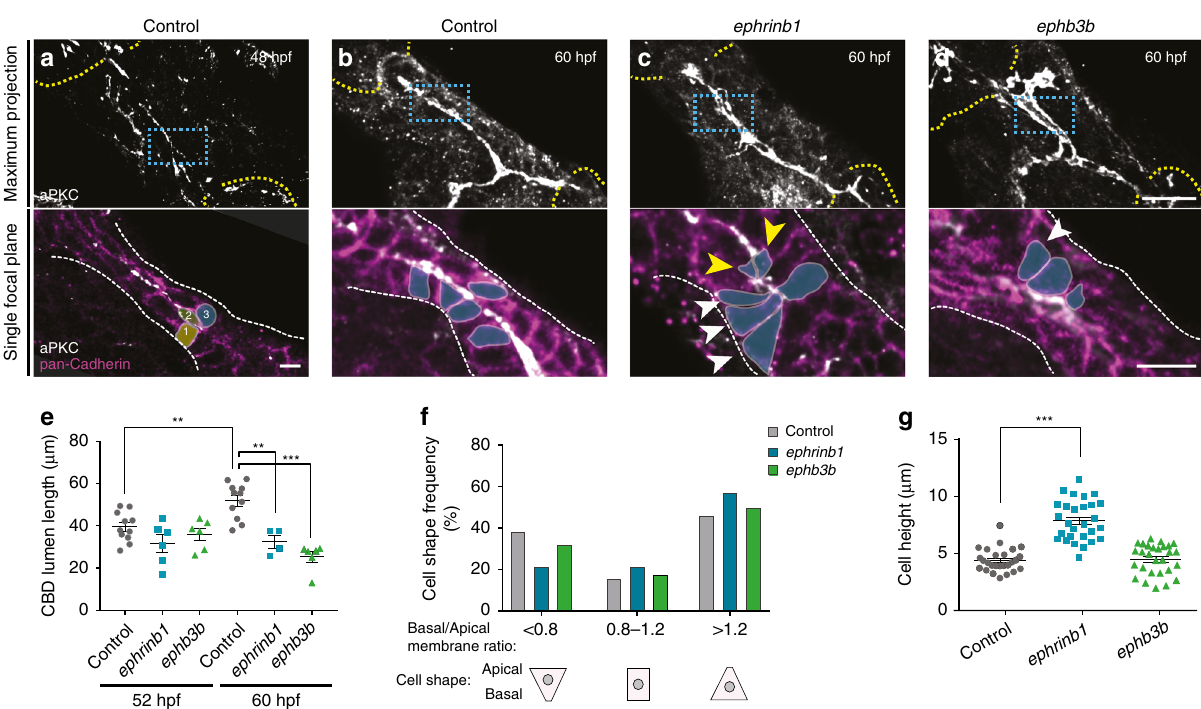
Fig. 3 Ductal cell rearrangement and lumen resolution require EphrinB1 and EphB3b. a – d Overview of the forming HPD epithelium by maximum projection of confocal stacks stained for PanCadherin (magenta) aPKC (white) in control and ephrinb1 and ephb3b mutants. Blue dashed squares indicate magni fi ed CBD containing areas. a At 48 hpf, PanCadherin shows multiple cell layers in CBD (e.g., colored cells 1 – 3). b By 60 hpf, the CBD is largely a single-layered epithelium with apical domains facing the central lumen. c , d ephrinb1 and ephb3b CBDs show disrupted epithelial organization, including luminal loops, with cells with multiple or extended apical domains (yellow arrowheads), and teardrop shaped-cells with reduced apical domains (white arrowhead). e Quanti fi cation of the longest continuous aPKC staining as a measure for CBD lumen elongation in controls, ephrinb1 and ephb3b mutants between 52 and 60 hpf. f Basal/apical membrane ratio was used to quantify CBD cell shapes in control ( n = 26 cells), ephrinb1 ( n = 28) and ephb3b ( n = 28) embryos at 60 hpf. g Quanti fi cation of CBD cell height (distance between apical and basal membranes) in control ( n = 26 cells), ephrinb1 ( n = 28) and ephb3b ( n = 28) embryos at 60 hpf. Scale bars: a = 5 μ m, b – d = 20 μ m. Statistical test: e , g = Student ’ s t -test, f = Fisher Exact. Errors bar show SEM; ** p < 0,01, *** p < 0,001. Source data are provided as a Source Data fi